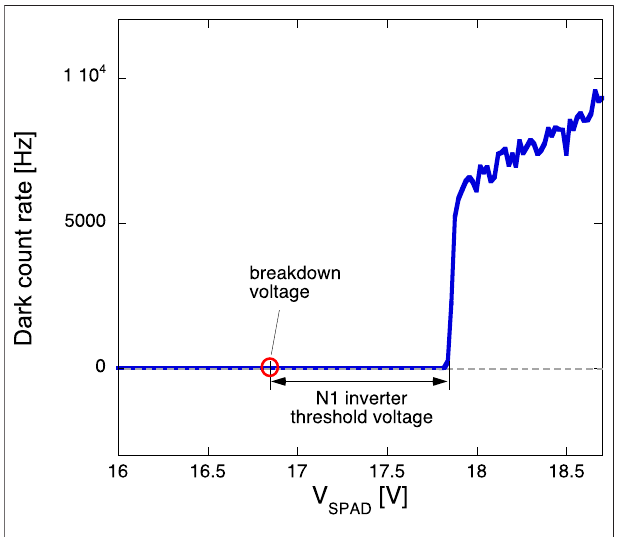
FIGURE 8 | Example of breakdown voltage